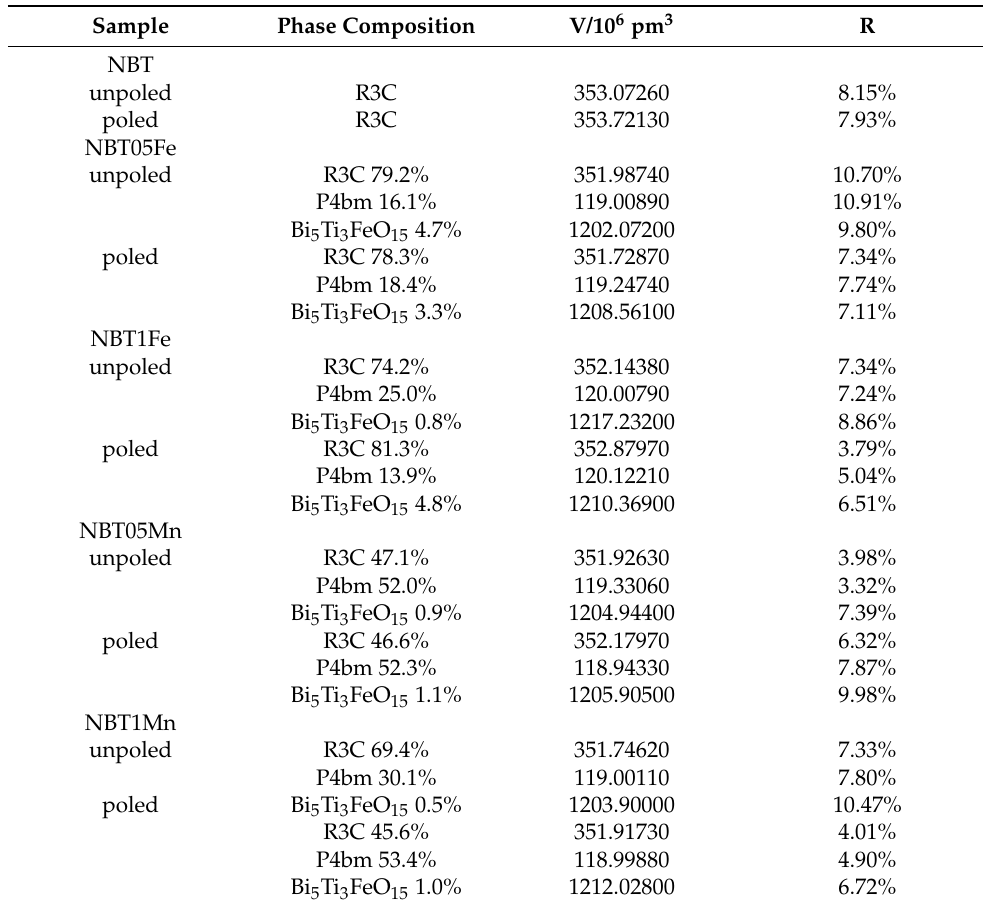
Table 1. Rietveld refinement results of NBT and Fe- and Mn-modified NBT. V is lattice volume, and R is weighted